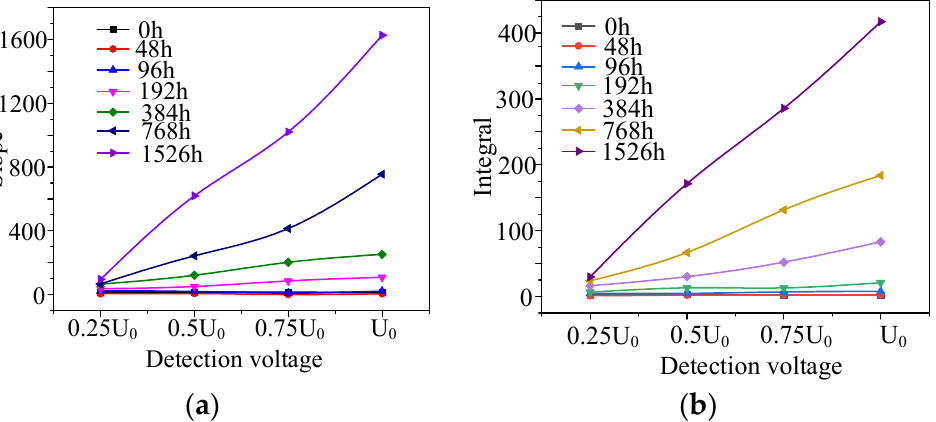
Figure 14. Slope K and integral S of different aging time versus detection voltage (1536 h): ( a ) slope K ; ( b ) integral S .